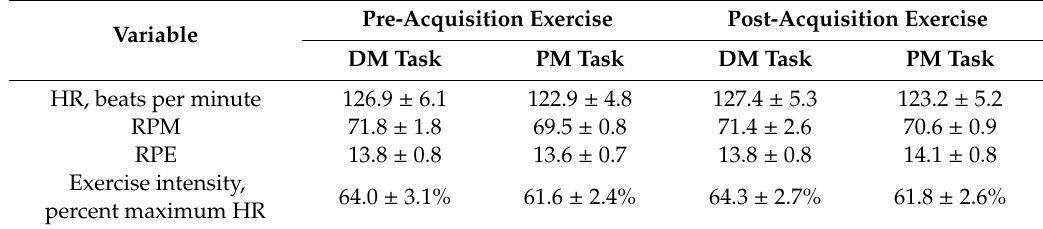
Table 1. Mean HR, RPE, and RPM ( ± SD) under pre- and post-acquisition exercise